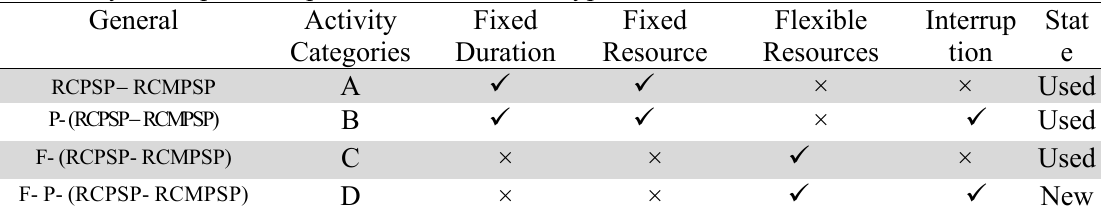
The activity assumptions implemented in different types of RCPSPs and RCMPSPs. General Activity Fixed Fixed Flexible Interrup Stat Categories Duration Resource Resources tion e A   × × Used   ×  Used × ×  × Used D × ×  